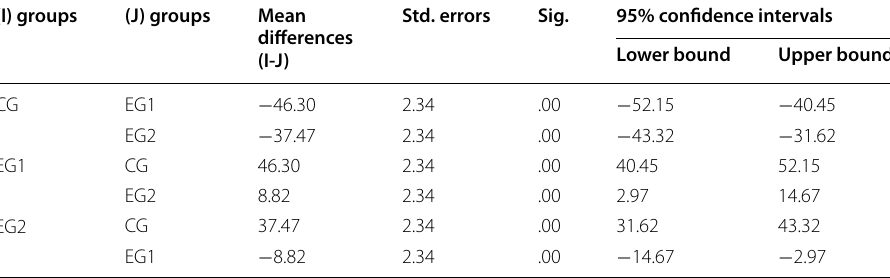
Table 14 Findings of the Scheffe post hoc test: the participants’ posttest of FLLM (I) groups